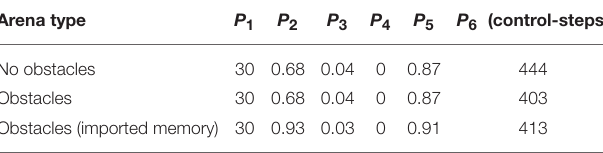
TABLE 2 | Performance of system for robot swarms in different